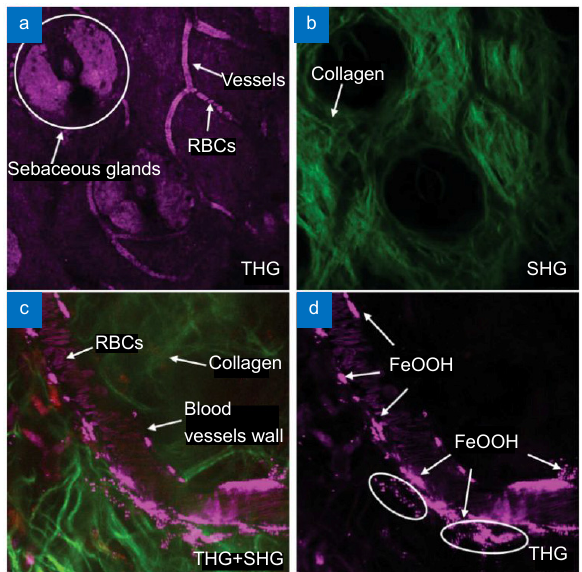
Fig. 6 | Third harmonic generation microscopic imaging of the tissues in vivo. ( a ) Third harmonic generation. ( b ) Second har- monic generation imaging of mouse ear in vivo. ( c ) Third harmonic generation and second harmonic generation. ( d ) Third harmonic generation imaging of the mouse ear after the injection of FeOOH nanoparticles. Size of view fields: (a, b) 240 µm × 240 µm, (c, d) 80 µm × 80 µm. Figure reproduced from: ref. 153 ,